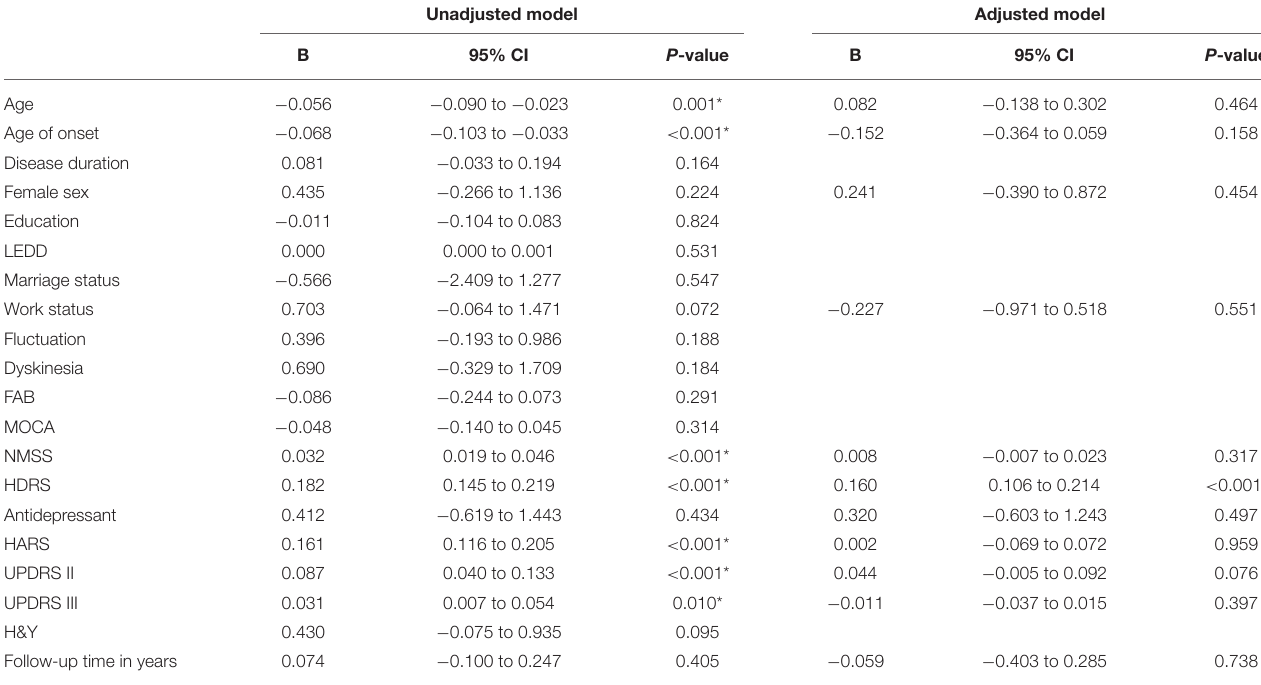
TABLE 2 | Factors associated with higher self-stigma scores in patients with PD.